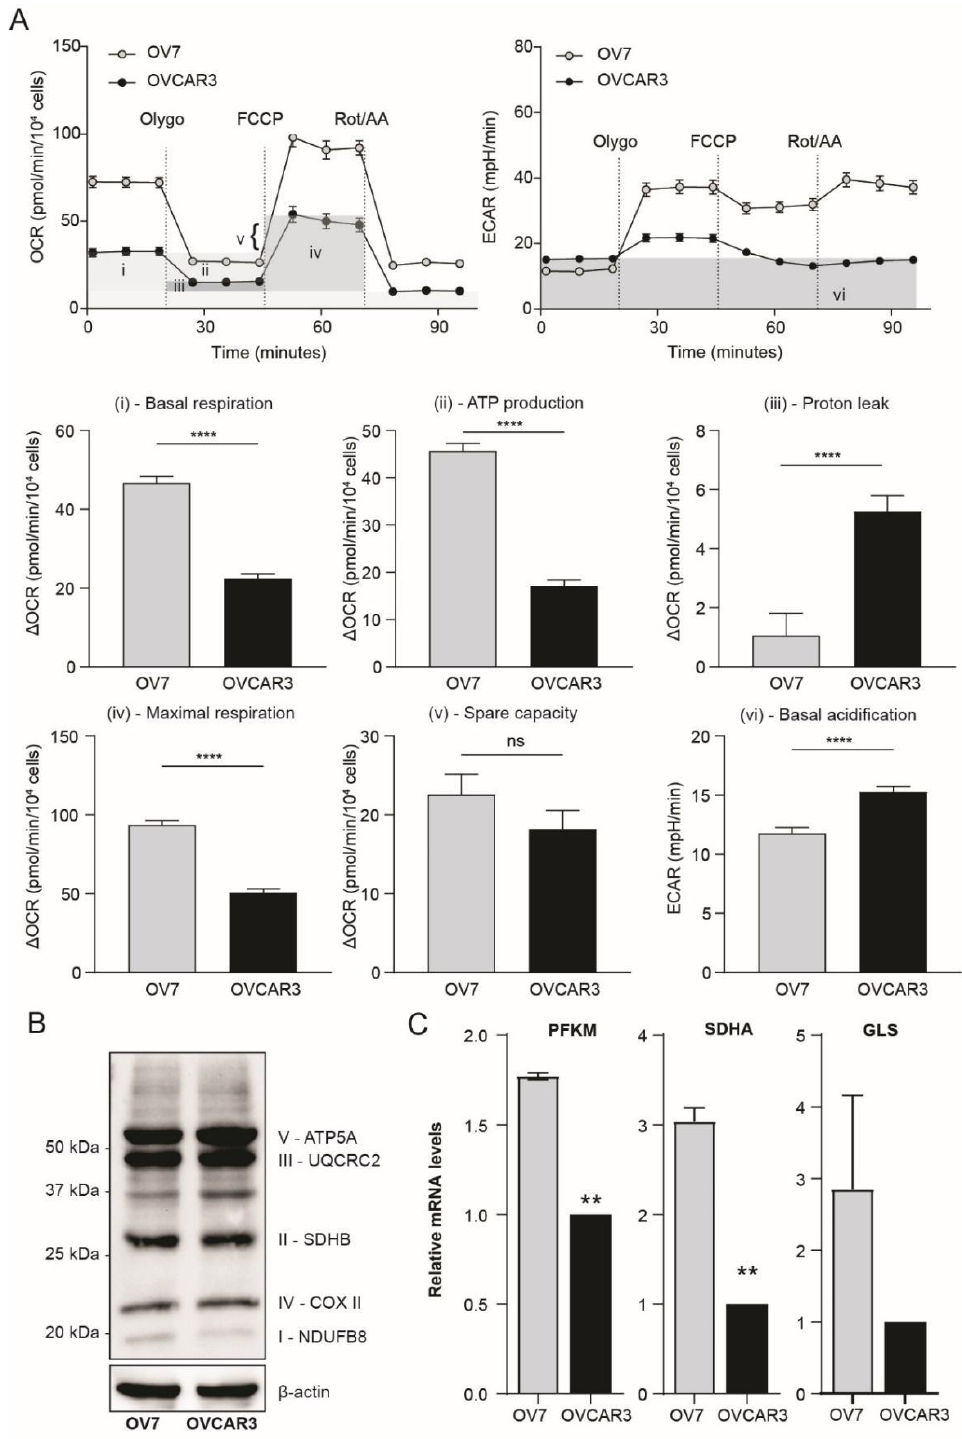
Figure 4. CL HGSOC cells have a high energy metabolism. ( A ) Seahorse XF Cell Mito Stress Test (OCR: oxygen consumption rate; ECAR: extracellular acidification rate) performed by Sea- horse platform in OV7 and OVCAR3 cells. Sequential treatments with Oligomycin, FCCP and Rotenone/Antimycin A were performed to enable quantification of basal respiration, ATP-linked respiration, proton leak, maximal respiration, spare respiration and basal acidification. ****, p < 0.0001 independent sample t test ( B ) Western blot analysis of oxphos protein complex subunits in OV7 and OVCAR3 cells. Beta actin was used as loading control. ( C ) mRNA levels of metabolic enzymes in OV7 and OVCAR3 cells measured by RT-qPCR. **, p < 0.01 independent sample t